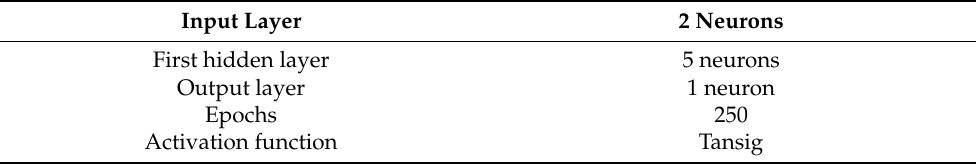
Table 1. Network characteristics for regime